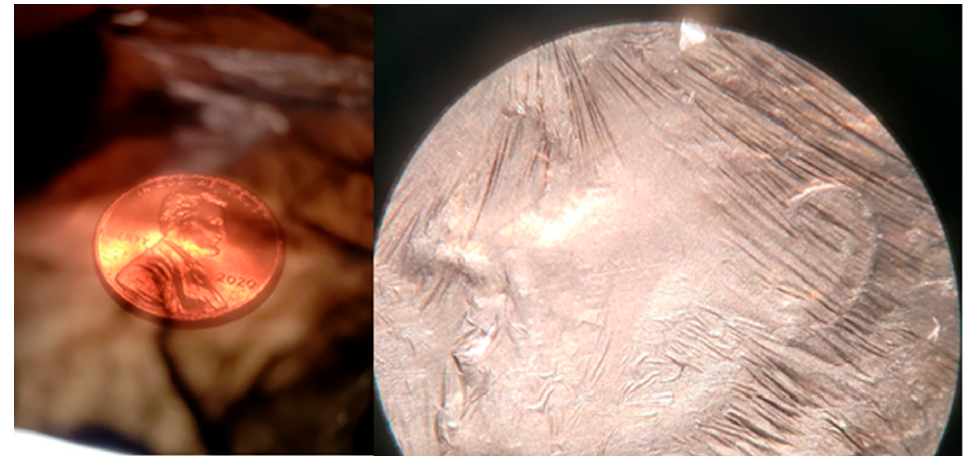
Figure 15. CNT film 2–3 microns thick is partly transparent, showing a US penny coin. CNT film covering a US dime coin.